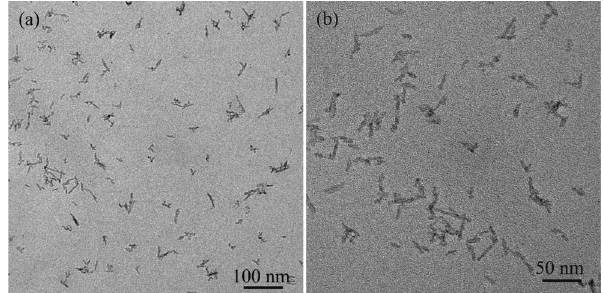
Fig. 2 TEM images of CuO nanorods prepared at 90 °C for 3 h with different magnification: (a) 40,000× and (b) 80,000× .